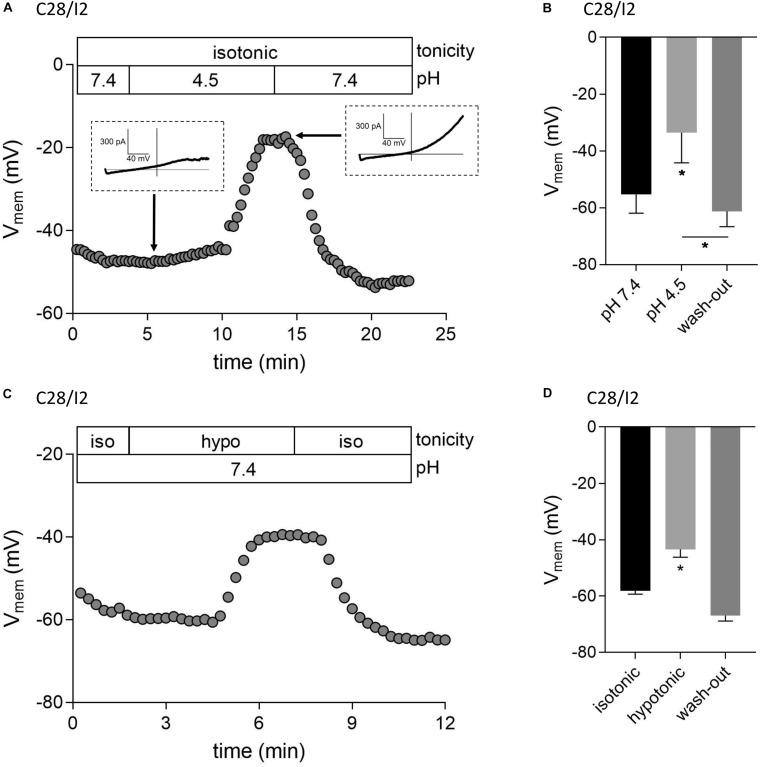
Acidic and hypotonic conditions lead to depolarization of the cell membrane potential (Vmem). Vmem recordings of single C28/I2 chondrocytes at pH 7.4, pH 4.5, and pH 7.4 again (wash-out) (A), and under isotonic (iso), hypotonic (hypo), and isotonic (wash-out) (C). Each circle represents the mean Vmem obtained over 15 s. Insets in (A) show whole-cell Cl– currents at the indicated timepoints in response to 500-ms voltage ramps from −100 to +100 mV from membrane potentials prevailing at the respective timepoints. (B,D) Mean Vmem ± SEM under the conditions given in (A) and (C) (n = 3 and n = 3–6, respectively). Asterisks in (B) indicate significant differences between pH 7.4 and pH 4.5 and between pH 4.5 and wash-out (p < 0.05). In (D), the asterisk indicates a significant difference between isotonic and hypotonic conditions (p < 0.05). Paired t-tests.